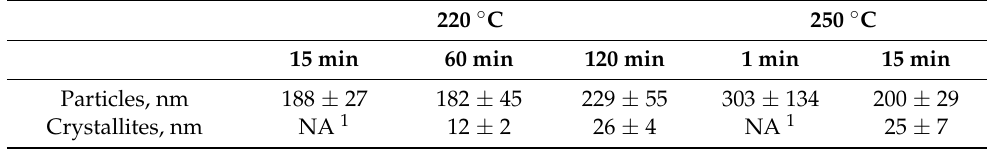
Table 2. Comparison of the Fe 3 O 4 particle sizes synthesized without PEG at different temperatures and times. Particles refer to the whole sized spheres, and crystallites are the small grains of which the particles are